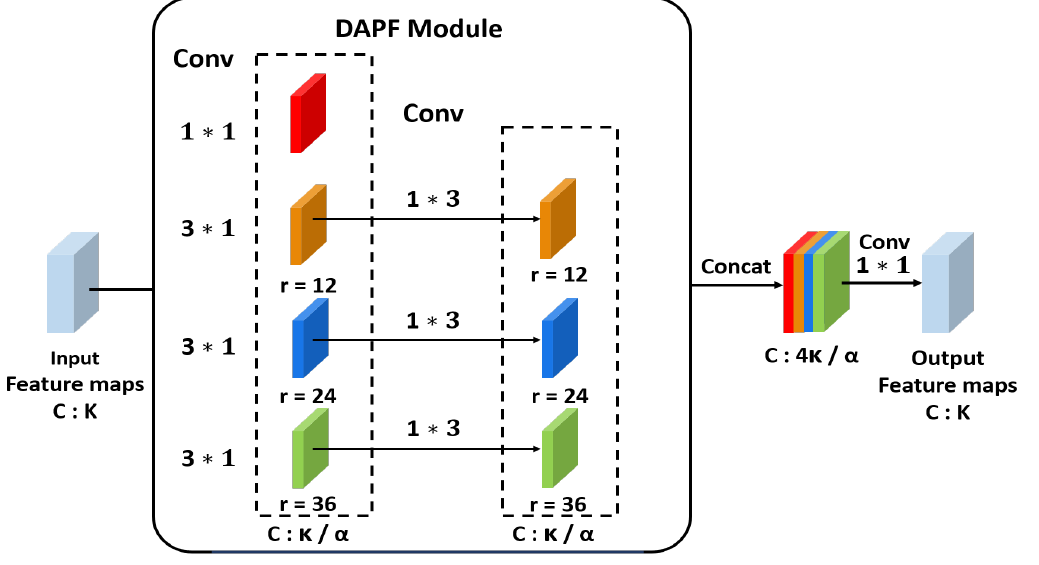
Figure 2. The DAPF